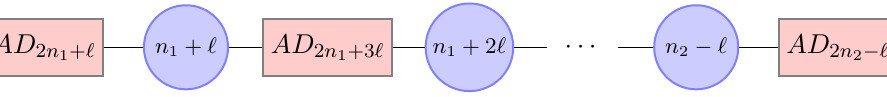
Figure 2 . The quiver diagram of the T ( ‘ ) n building block for the larger quiver we will consider 1 ;n 2 in (cid:12)gure 3 and focus on in the next section. Here ‘ is a positive odd integer, and n 1 and n 2 are two integers such that ( n 2 (cid:0) n 1 ) =‘ is a positive integer. The gauge group of the quiver is SU( n 1 + ‘ ) (cid:2) SU( n 1 + 2 ‘ ) (cid:2) (cid:1) (cid:1) (cid:1) (cid:2) SU( n 2 (cid:0) ‘ ). The (cid:13)avor symmetry is U( n 1 ) (cid:2) U(1) n 2 (cid:0) n 1 ‘